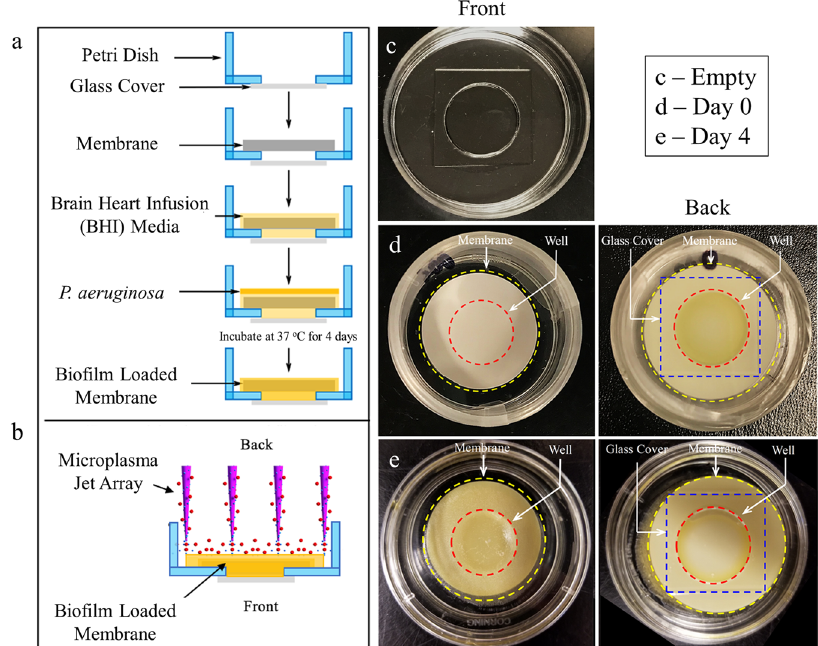
Fig. 4 P. aeruginosa bio fi lm grown on an eardrum-mimicking membrane. a P. aeruginosa bio fi lm protocol for the eardrum-mimicking membrane. b Final diagram of the bio fi lm phantom and the direction of microplasma jet array treatment. c Photo of an empty glass bottom cell culture dish. d Photos of the membrane immediately after loading the bacterial suspension. e Photos of 4-day-old bio fi lm on the membrane.